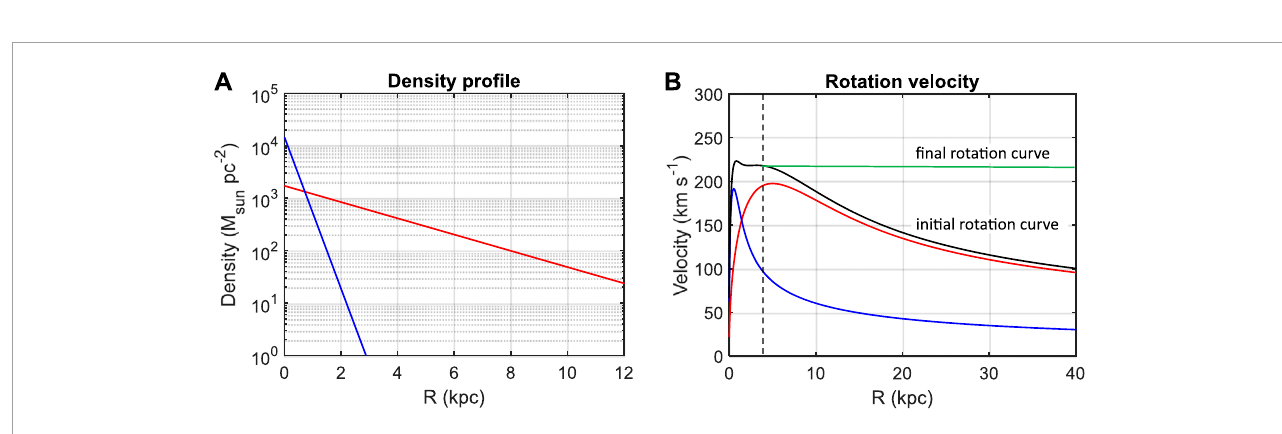
FIGURE 2 The density profile (A) and the initial and final rotation velocity curves (B) for a simulated galaxy. The surface densities of the bulge (blue line in (A) ) and disk (red line in (A) ) are calculated by Eqs 31 , 32 with Σ b ( R b 0 ) = 3.6 M ⊙ pc −2 , R b 0 = 2.5 kpc, R b = 0.3 kpc for the bulge, and with Σ d ( R d 0 ) = 99.2 M ⊙ pc −2 , R d 0 = 8.0 kpc, R d = 2.8 kpc for the disk. The total masses of the bulge and disk are M b = 8.5 × 10 9 M ⊙ and M d = 8.5 × 10 10 M ⊙ , respectively. The total initial rotation velocity (black line in (B) ) is shown together with the contribution of the bulge (blue line in (B) ) and disk (red line in (B) ). The vertical dashed line in (B) defines the boundary R c = 4 kpc between the bulge-bar regime and the trailing-spiral regime. The green line in (B) shows the final rotation curve caused by the space expansion (the stellar mass and gas with R > R c are continuously moving out of the galaxy centre, but they keep their rotation